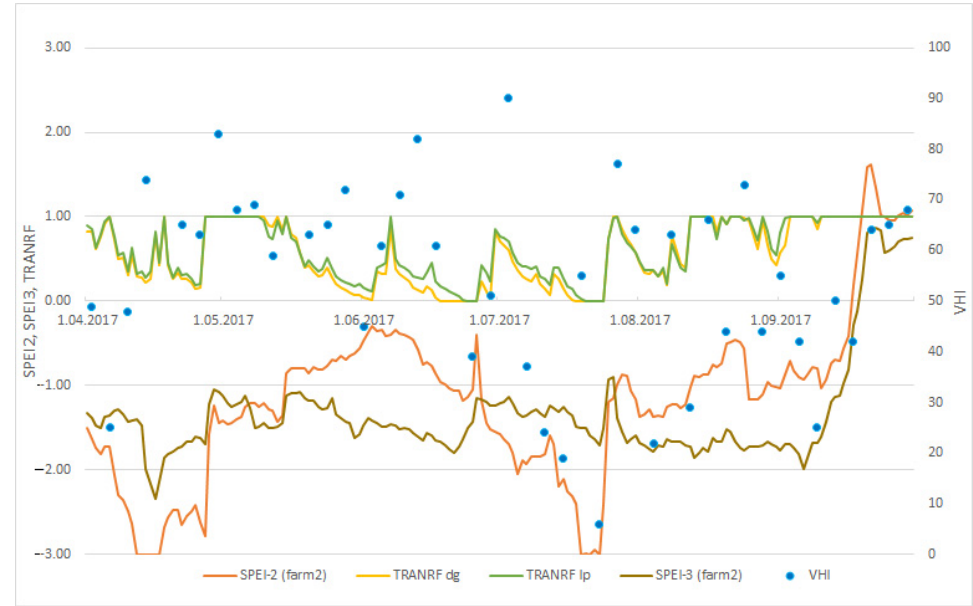
Figure 7. Time series of the LINGRA-N model results of drought factor (TRANRF) using the parameter set calibrated for Dactylis glomerata in Jablje (dg) and Lolium perenne in Jablje (lp); time series of drought indices (VHI, SPEI-2 and SPEI-3) for Farm 2, all for 2017.